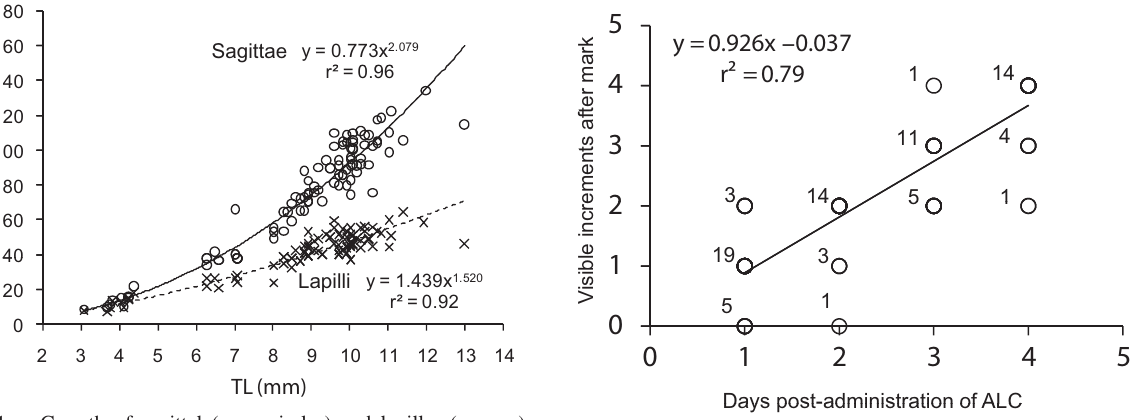
Fig . 1. – growth of sagittal (open circles) and lapillar (crosses) otoliths (as measured along the longest radius) on total fish length Fig . 2. – relationship between the number of days subsequent to (tl) for the fed larvae from both experiments up to 28 days of age immersion of larvae in Alc and the number of increments visible (n = 97). All data points plotted are the means for the left and the after the fluorescent mark. the regression was fit using all the points right otoliths. (numbers shown close to each dot). each observed mean marked